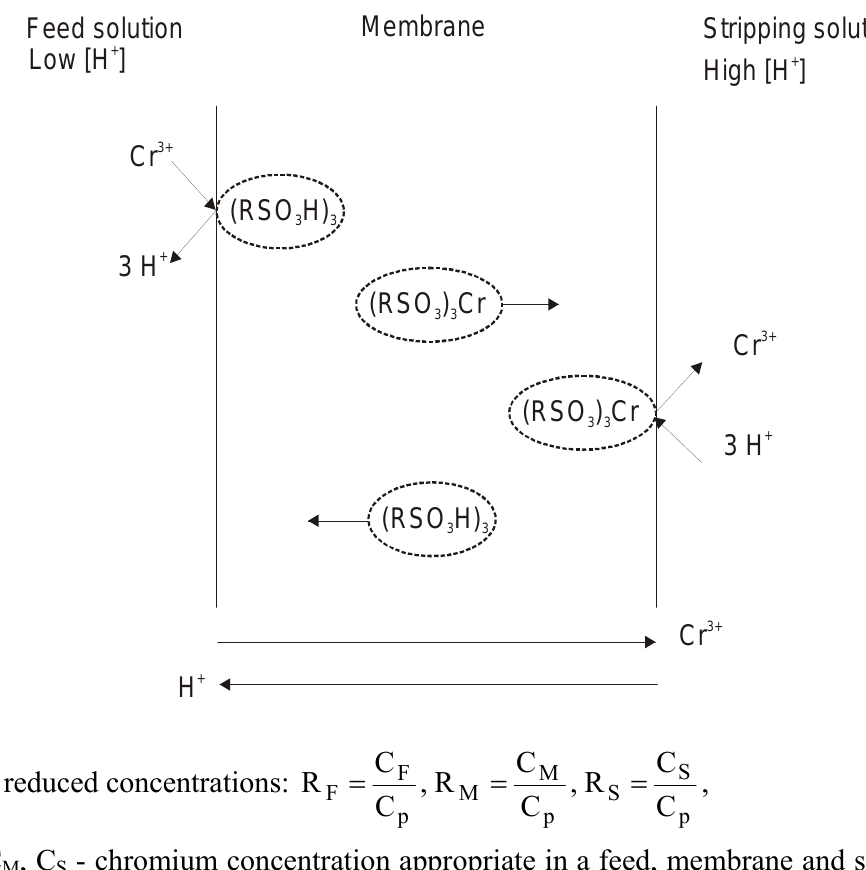
Figure 2. Schematic description of coupled counter transport of